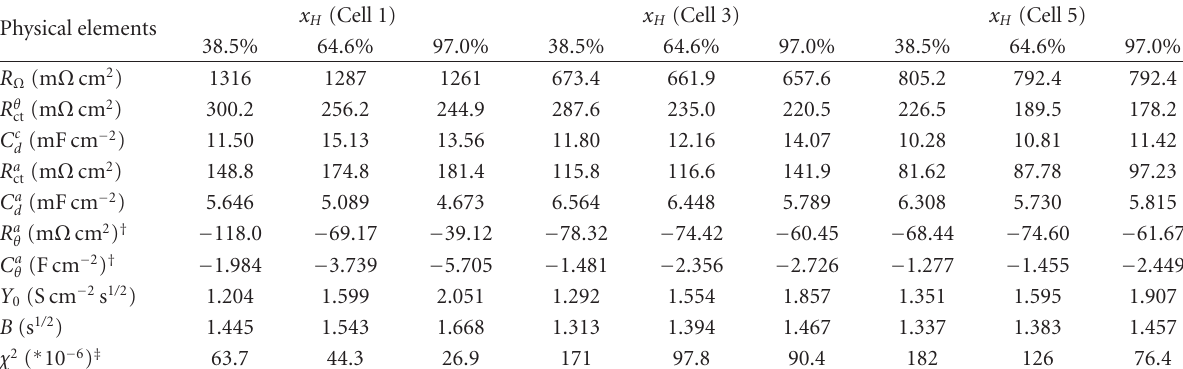
† Negative values of R θ and C θ indicate that the inductive behavior of anode adsorbed intermediates is more significant than the capacitive portion. The same fits can be obtained without negative values, when the parallel R θ - C θ is replaced with a series R L -L moved in parallel with the anode R a ct [21]. ‡ χ 2 is the nonlinear least squares residual.